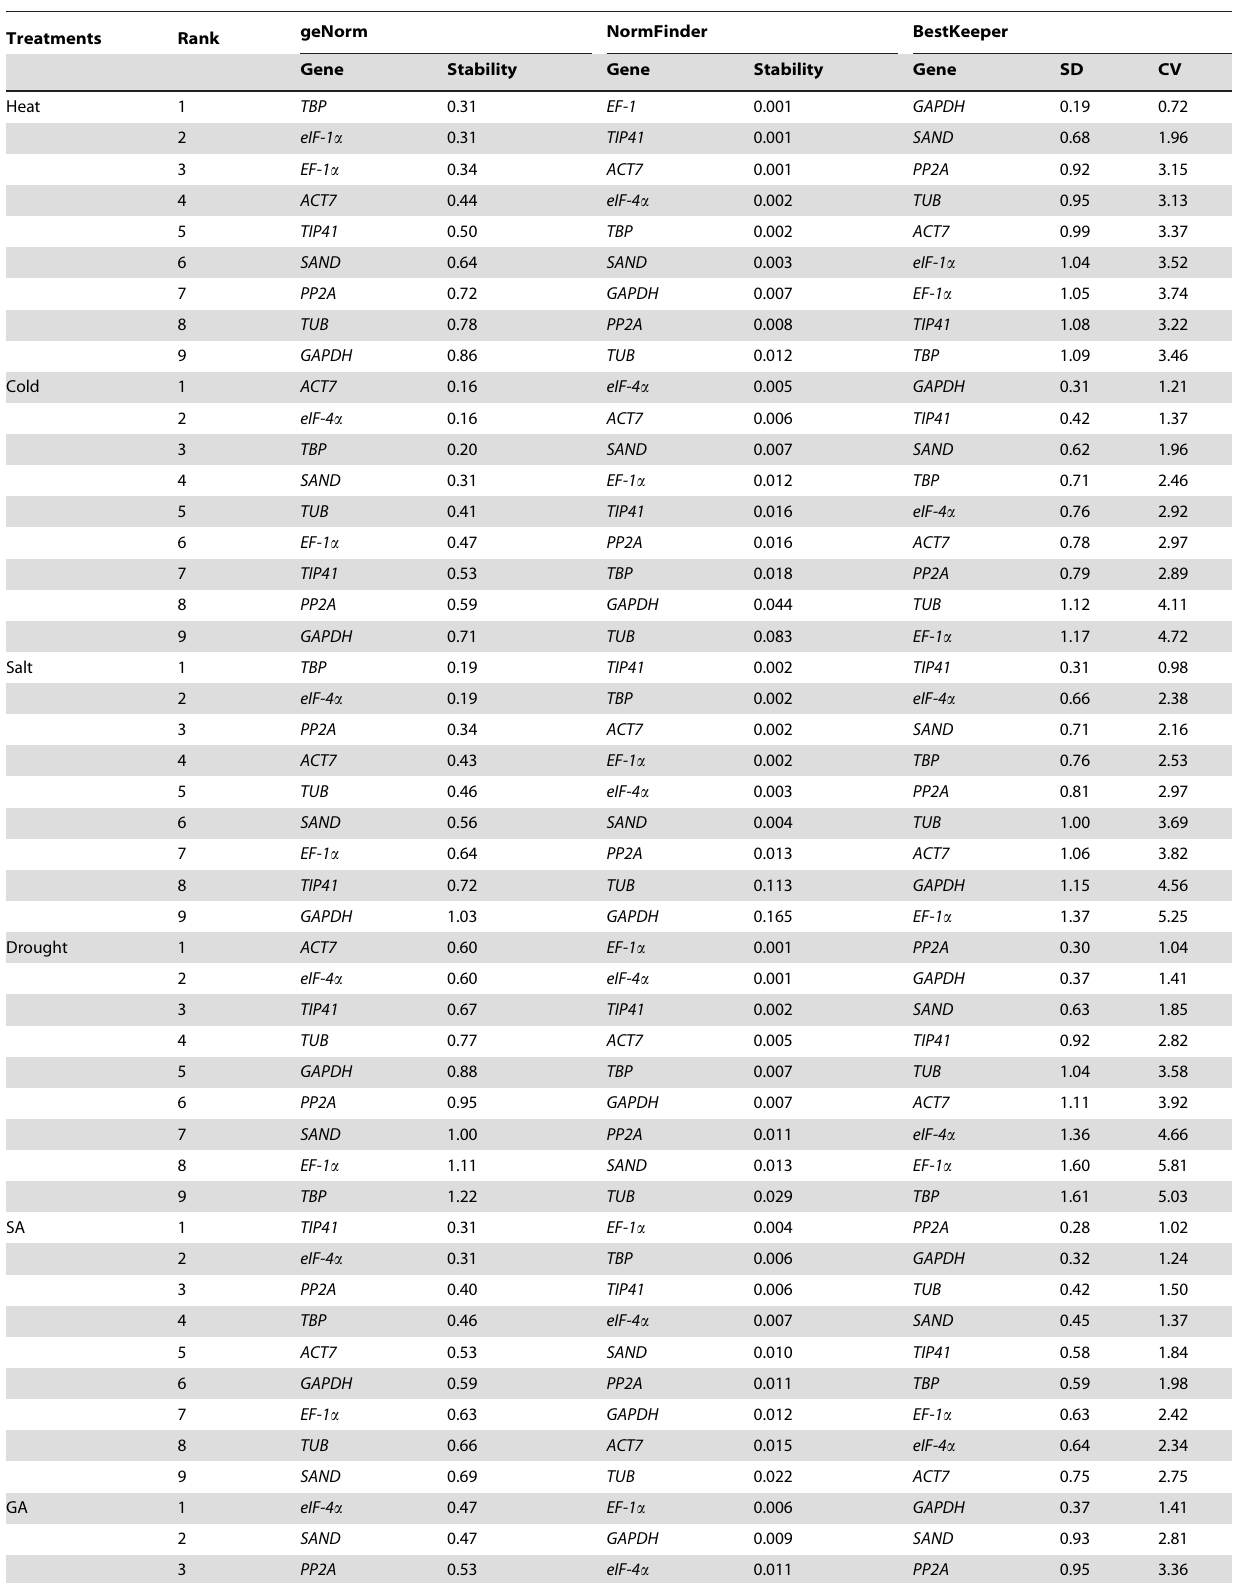
Table 2. Gene expression stability under individual stress ranked by geNorm, NormFinder and BestKeeper.